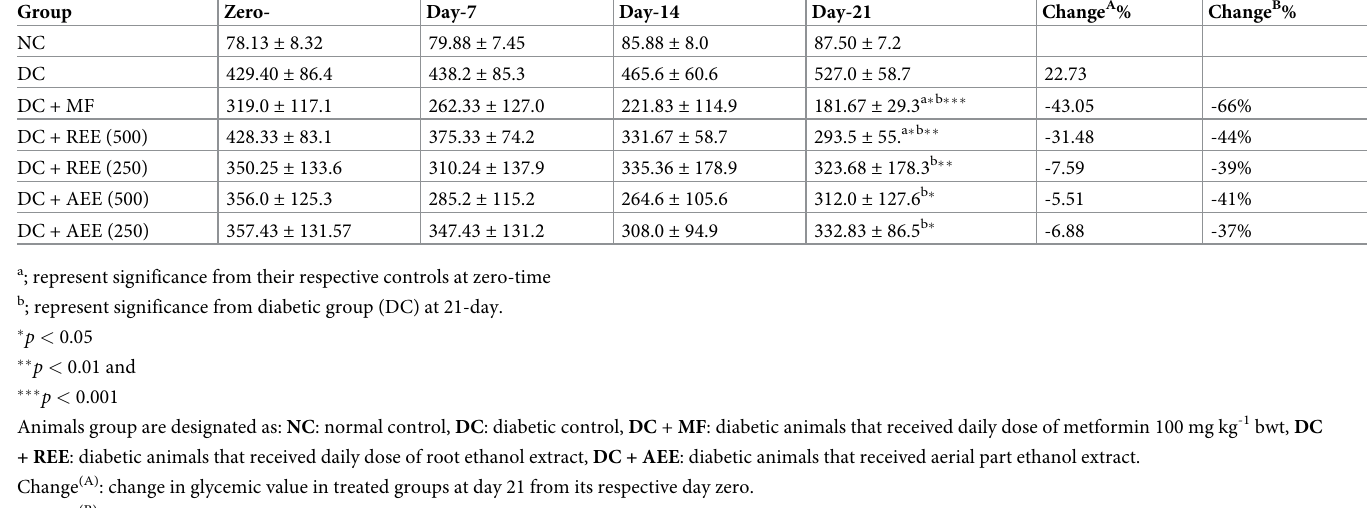
Table 2. Effect of REE, AEE and metformin on serum glucose concentration (mg/dL) in diabetic adult male rats. Group